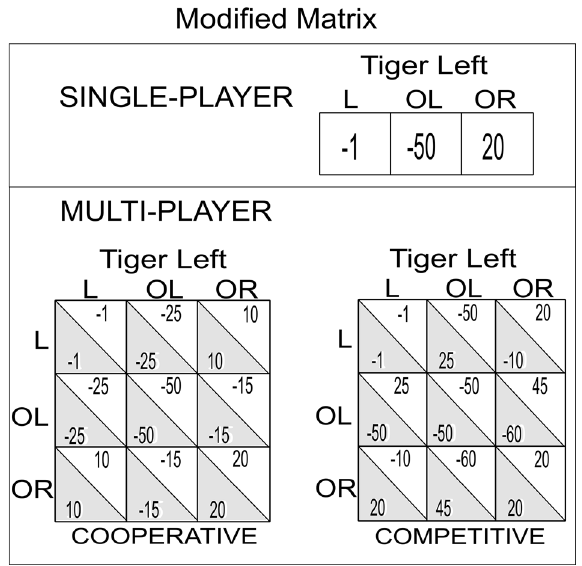
Figure 4. Modified payout structure of the Tiger Tasks. The payouts are potential points that can be gained for a chosen action (listen (L) and open-left/right (OL/OR)), when the tiger is behind the left door. The points scheme remains the same for the tiger behind the right door if we switch the OL and OR columns and rows. In the single-participant setting, a L action costs -1 points. Getting the gold-pot rewards +20 points while encountering the tiger takes away -50 points. In the multiagent setting, the column actions represent one’s own actions, while the row is the other participant’s actions. The point system is similar from the single-participant setting but more context dependent combinations are added as the other participant’s actions affect the points a participant can make.